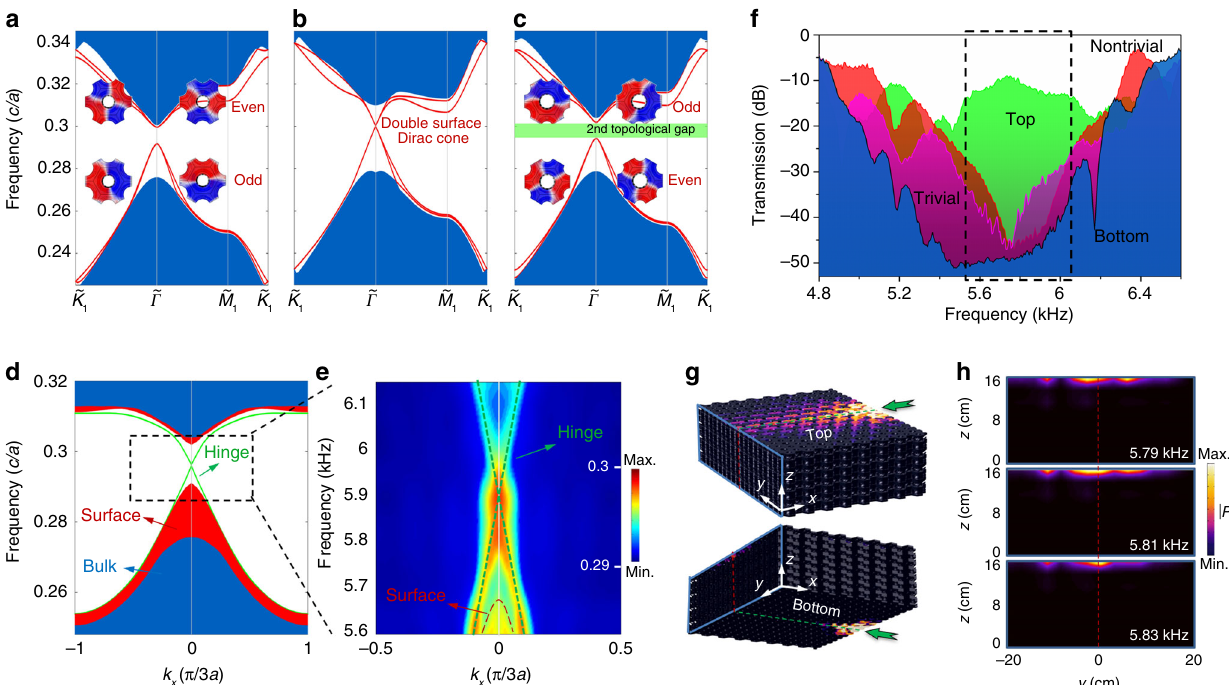
Fig. 4 Observation of the acoustic analogue of 3D 2nd-order TI. a Trivial surface bandgap when increasing the radii of the side holes. b Double-surface Dirac cone case. c Nontrivial surface bandgap when increasing the radius of the center hole. The insets show a top-down view of the acoustic fi elds of the surface states. d Numerically calculated projection of the 3D bandstructures onto the 1D k x direction, where the colours blue, red and green represent the bulk, surface and hinge states, respectively. e Measured dispersion of hinge states, where the colour scale represents the acoustic energy density. The dashed lines are drawn to guide the eye. f Experimental transmission spectra of the trivial surface case (magenta), nontrivial surface case (red), bottom (blue) and top (green) hinges. The dashed box indicates the frequency range for the surface bandgap. g Simulated acoustic pressure distributions for the top and bottom hinges at a frequency of 5.81 kHz. h Measured acoustic pressure distributions in the outgoing plane at various frequencies. The colour scale represents the absolute value of acoustic